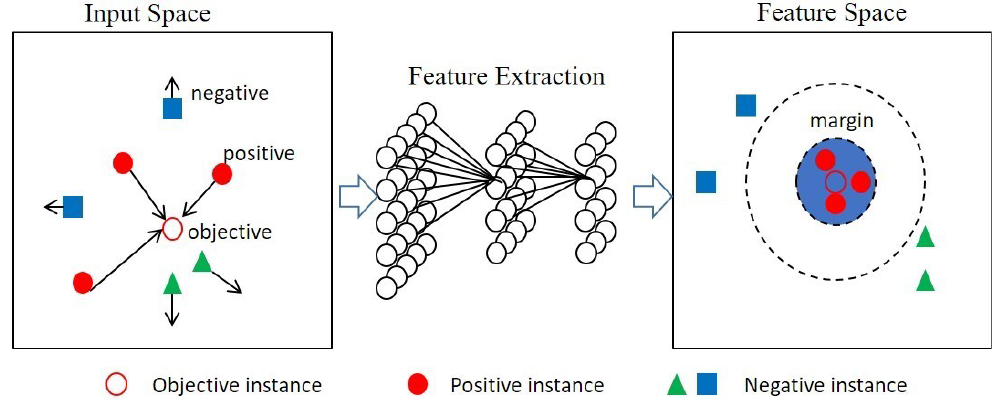
Figure 2: Schematic illustration of our proposed DLMNN. Deep neural network transforms samples from input space into feature space so that positive samples lie within a small radius and negative samples lie outside with a